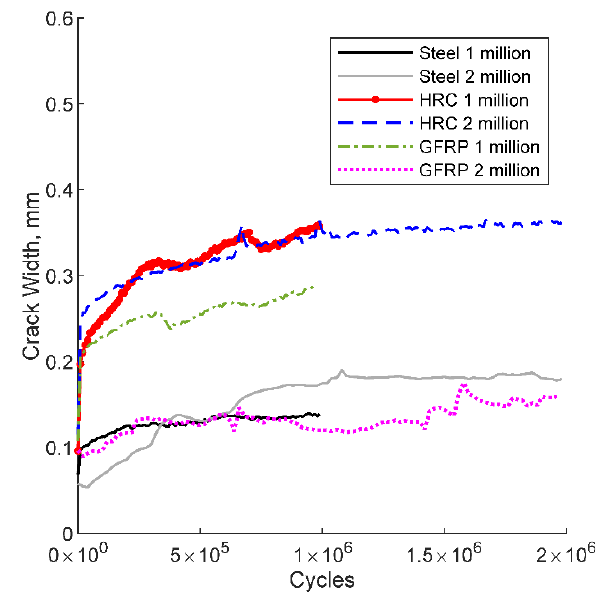
Figure 7. Deflection vs. No. of cycles.